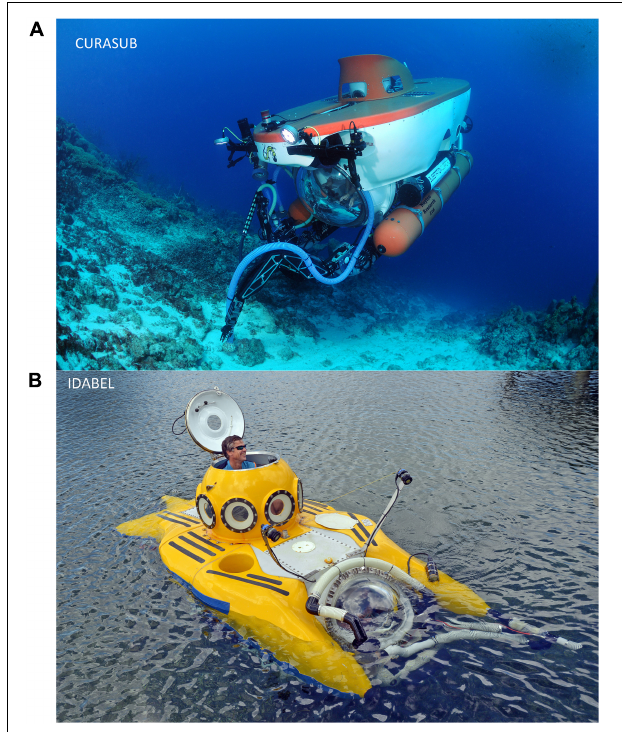
FIGURE 1 | The two submersibles used by the Deep Reef Observation Project (DROP) to conduct the research and collections described in this paper. (A) Curasub. The S shaped suction tube of that submersibles fish-catching system is visible on the near front side of the vessel, with the slender S shaped tube that delivers anesthetic in the background. Photo: Barry Brown. (B) Idabel. Idabel was temporarily equipped with a fish collection system equivalent to that on Curasub during DROP research. That system is visible as the cluster of white tubing around the front dome and extending forward of the far front side of the submersible, with the owner and pilot Karl Stanley, maneuvering Idabel on the surface. Photo: